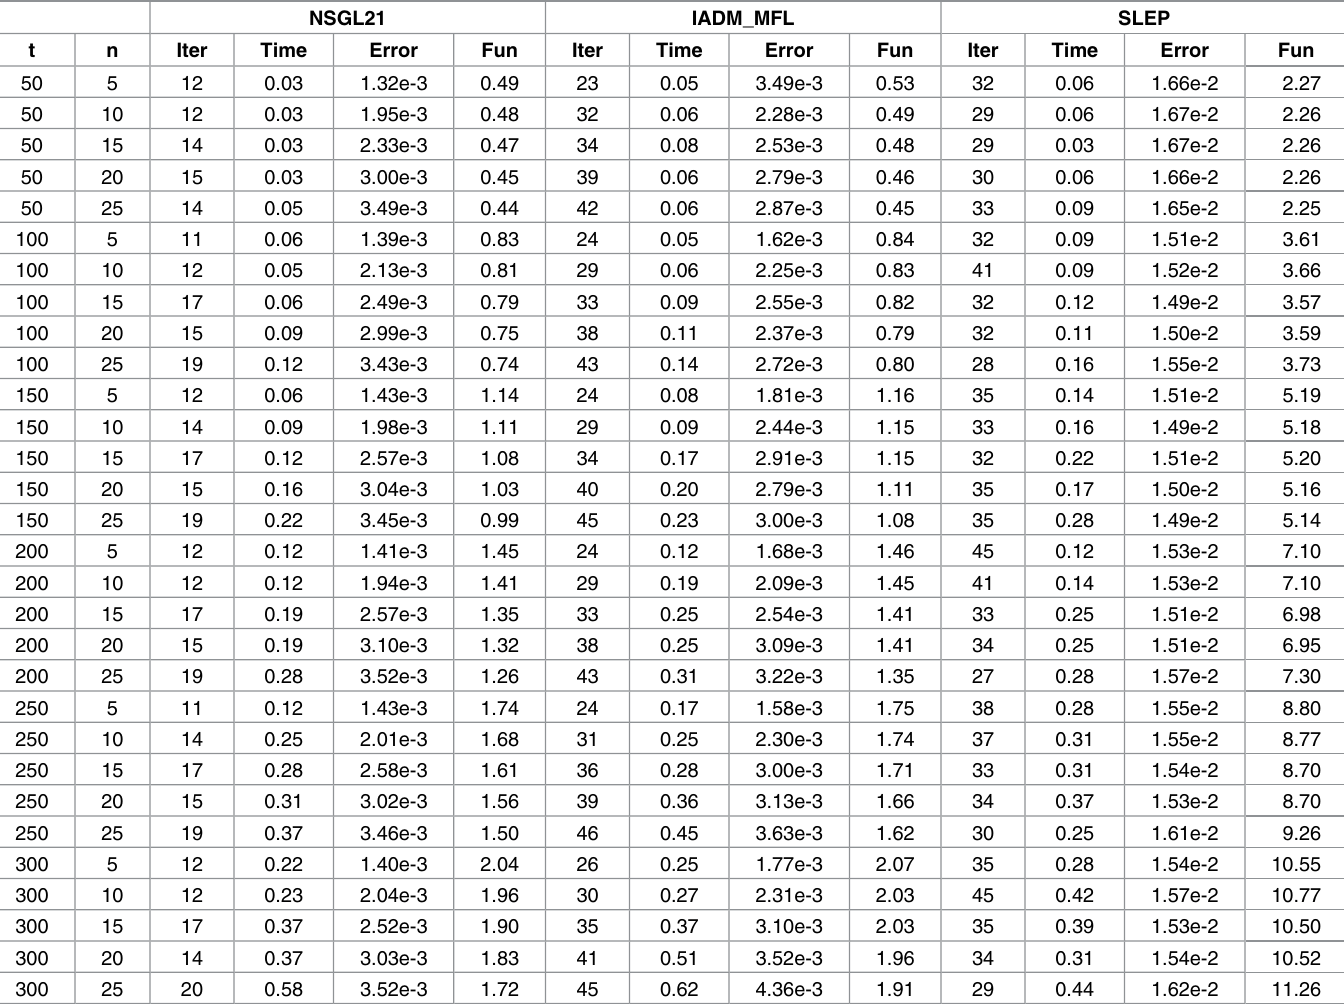
Table 1. Comparison results of NSGL21 with IADM_MFL and